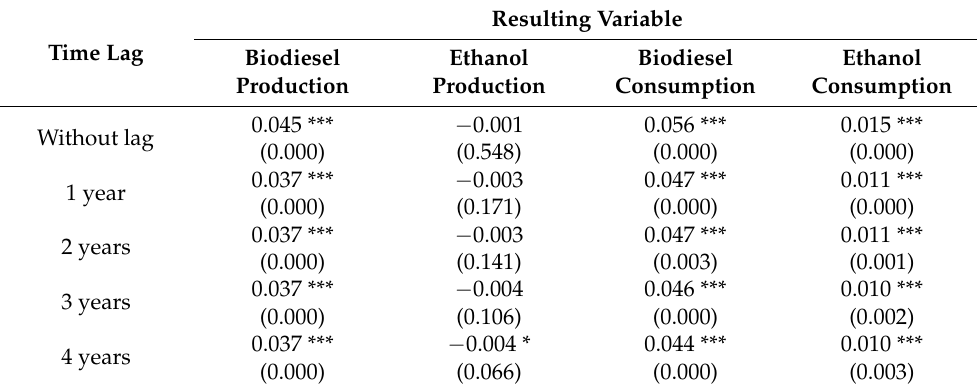
Table 7. Results of the assessment of energy taxes impact on the production and consumption of different types of biofuels in the European countries for